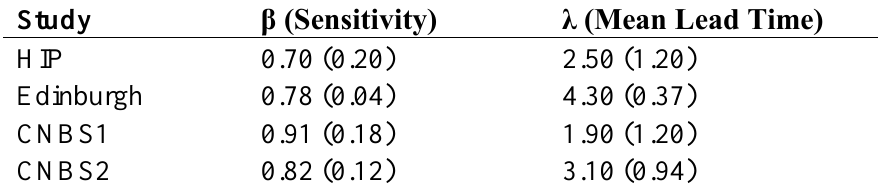
Table 1. Parameter estimates for the four screening